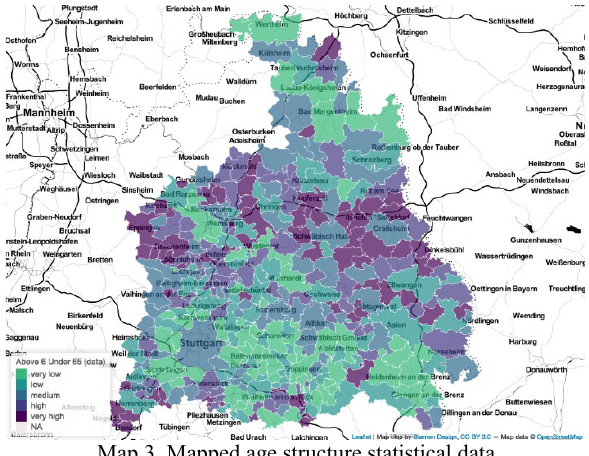
Map 3. Mapped age structure statistical data